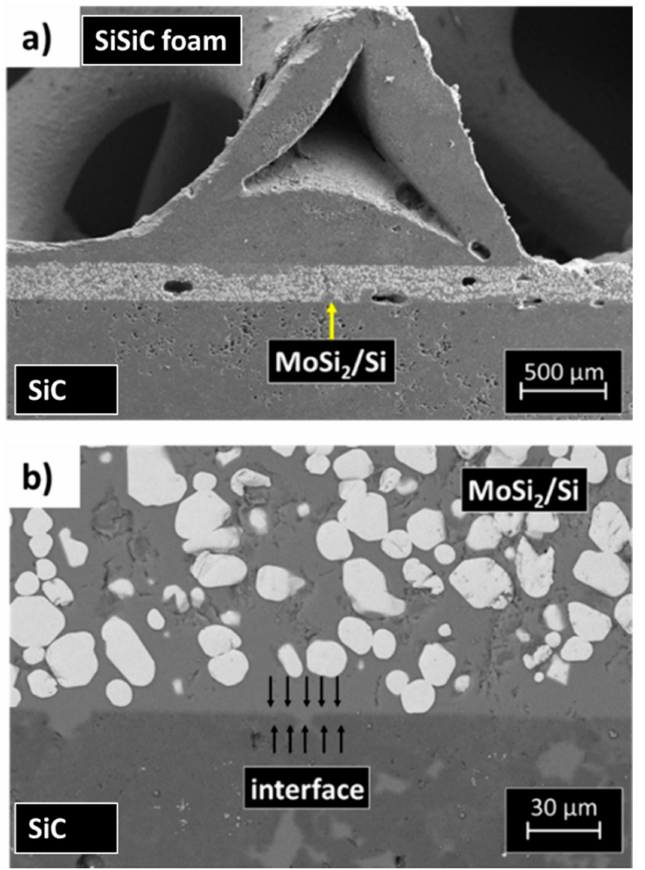
Figure 10. SEM cross-sections of a SiC-SiSiC foam sandwich ( a ) prepared by means of the Mo-Wrap joining technique; magnification of the substrate/joining material interface ( b